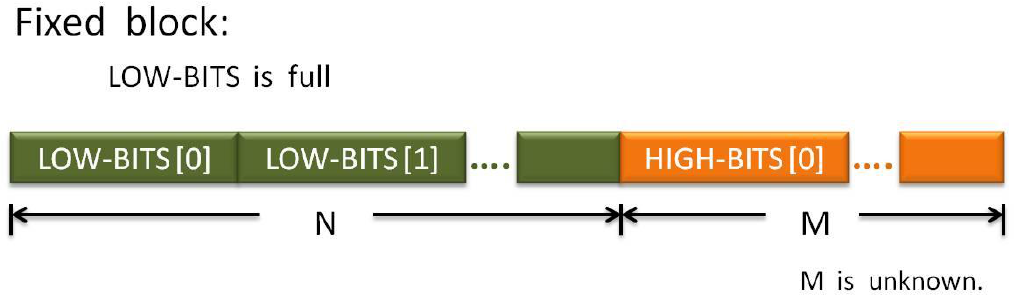
Figure 6. Fixed-block mode output format.